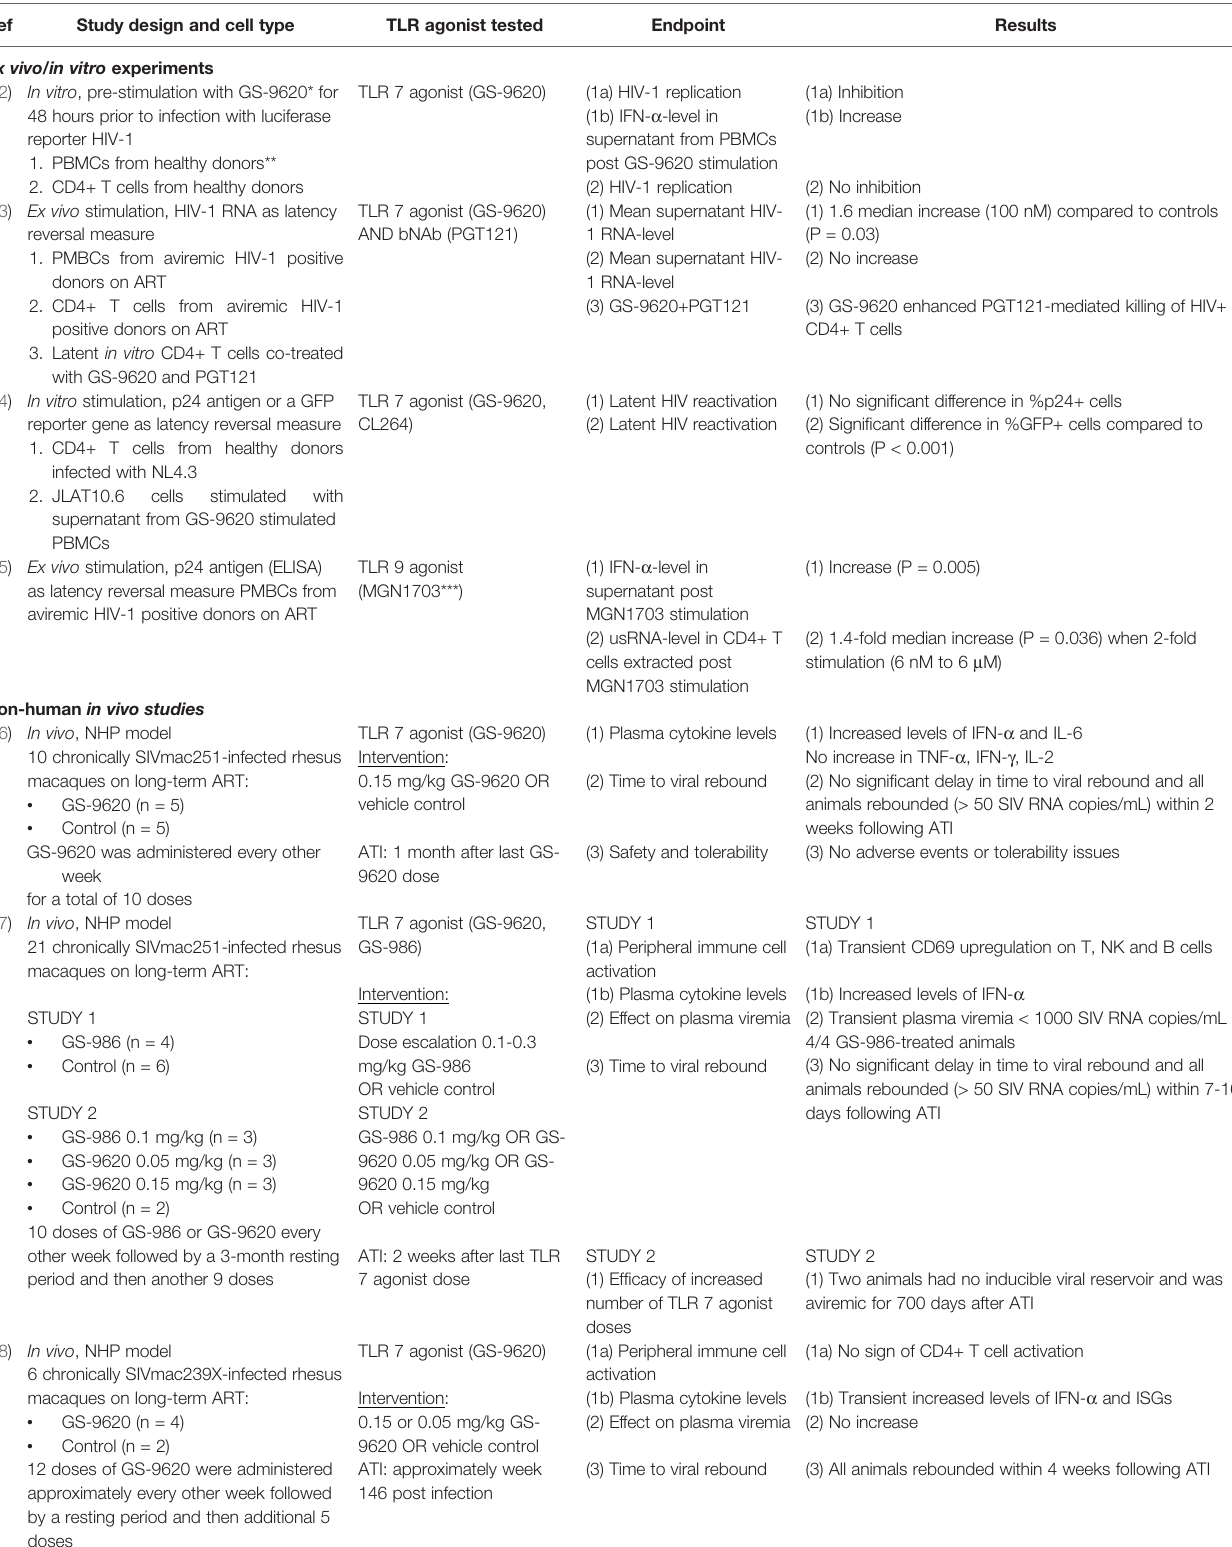
TABLE 1 | Studies investigating TLR7 and 9 agonists as LRAs and immune stimulators.